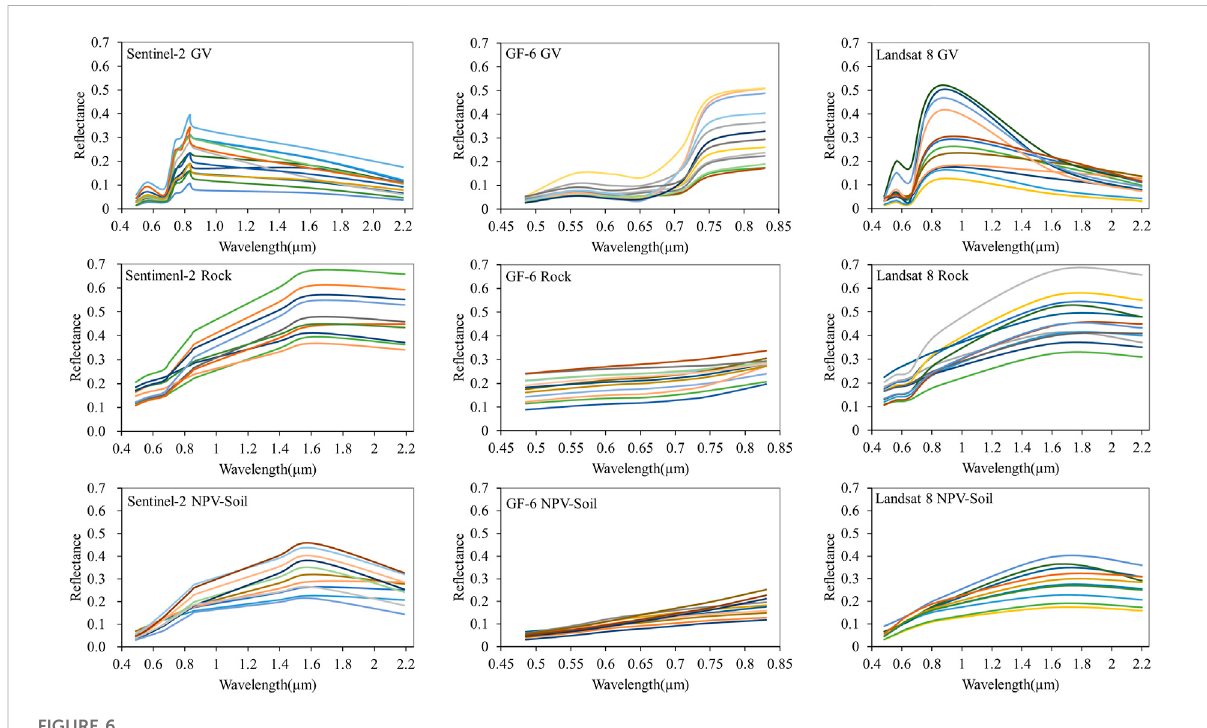
FIGURE 6 Endmember spectra of GV, BR and NPV-BS were used in